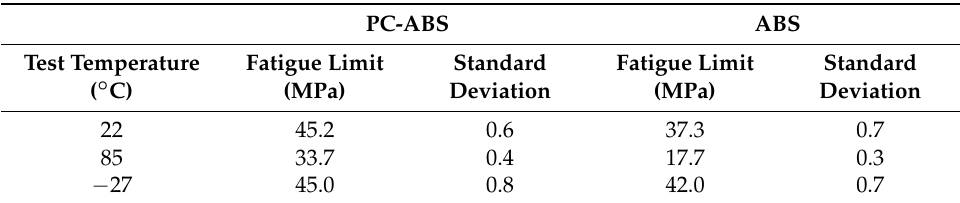
Table 2. Fatigue limits of PC-ABS and ABS at different temperatures